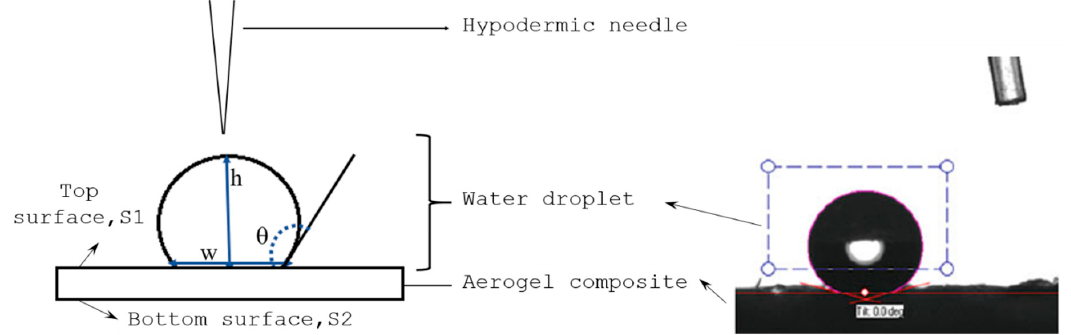
Figure 4. Contact angle measurements using water drop test.